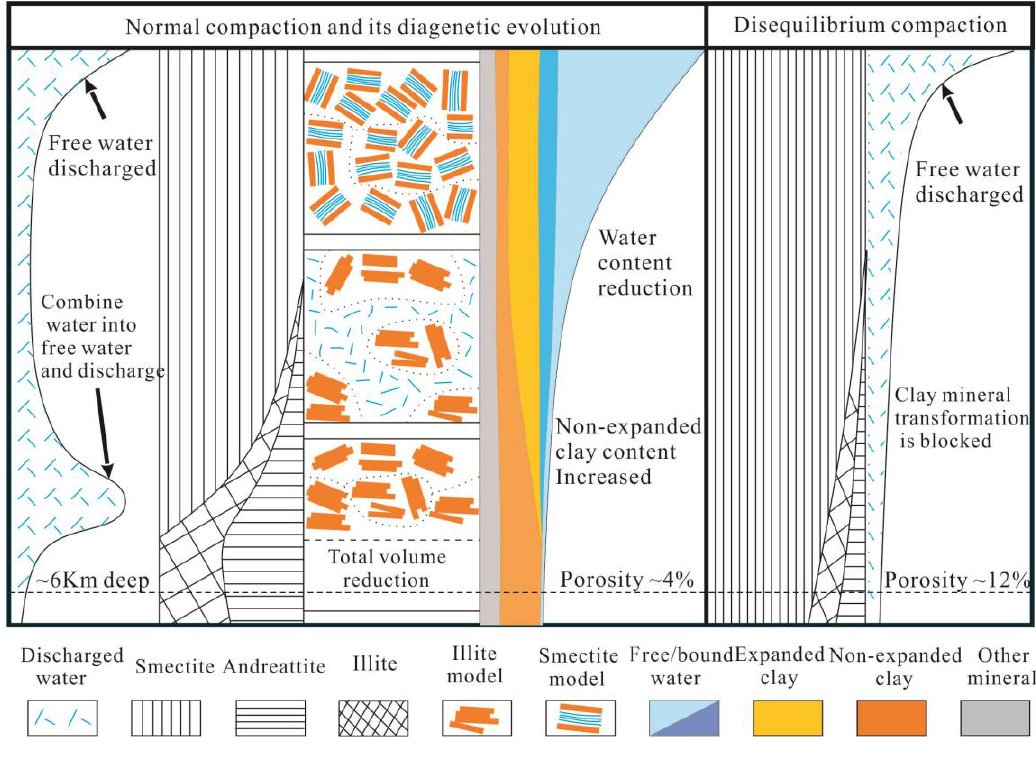
Figure 11. Clay mineral transformation under normal compaction and disequilibrium compaction conditions.